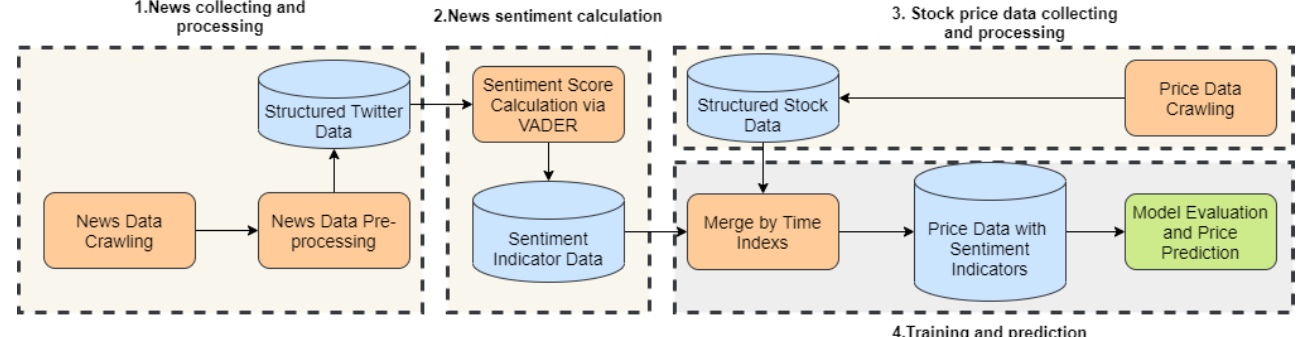
Figure 1. The workflow for forecasting stock using news data in Li